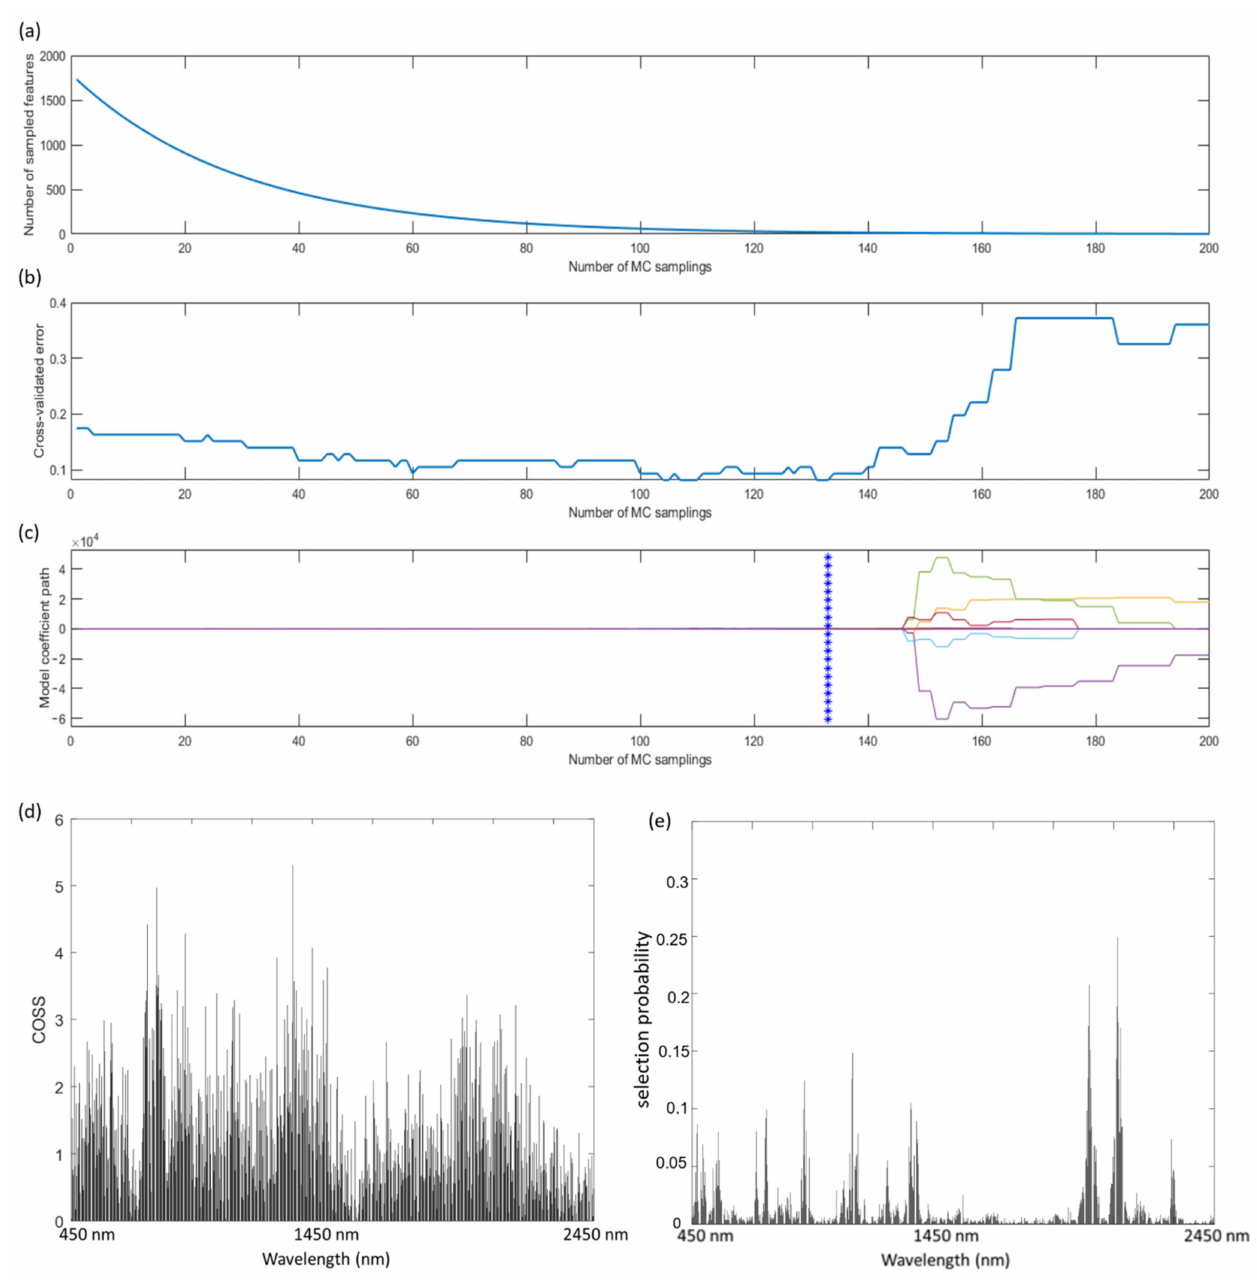
Figure 5. Competitive adaptive reweighted sampling (CARS) variable selection with top panel ( a ) indicating the number of Monte Carlo (MC) samples and rate of selection. The middle panel ( b ) indicates cross-validated error based on progression of the selection process, while the bottom panel ( c ) indicates trends in regression coefficients of individual wavelengths over the course of the sampling runs with each wavelength represented by a coloured line and the asterisk line indicating the subset with the lowest root mean square error (RMSE) of cross-validation identified after 133 sampling runs. ( d ) Sub-window permutation analysis (SPA) variable selection chart of conditional synergetic score (COSS) values with the most important wavelengths having higher scores. ( e ) Random frog (RF) selection probability with higher scores indicating the most important